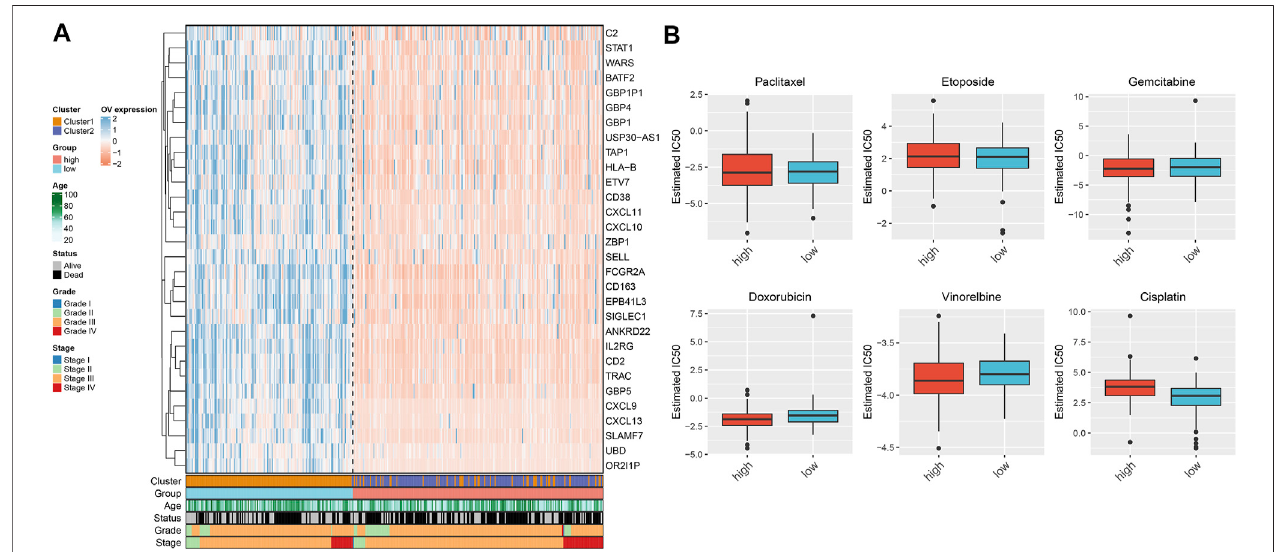
FIGURE 6| This immunescore is associated with chemotherapeutic responsesof OC patients. (A) Heatmap visualizing the expression distributions of prognosis- relevant characteristic immune subtype – derived genes across OC patients. (B) The difference in estimated IC 50 values of chemotherapeutic agents (paclitaxel, etoposide, gemcitabine, doxorubicin, vinorelbine, and cisplatin) in high and low immune score